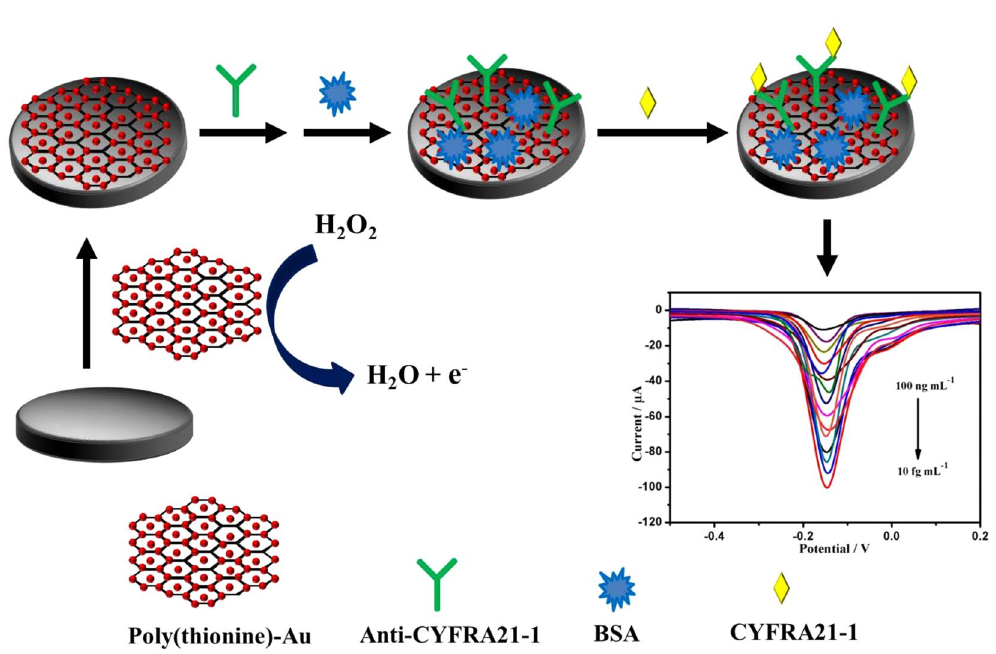
Figure 2. The poly(thionine)-Au nanocomposite exhibited strong redox activity at − 0.15 V ( A ), ameperometic response of poly(thionine)-Au for successive addition of 5 mM H 2 O 2 ( B ), and the EIS of bare GCE (curve a), GCE modified with poly(thionine)-Au (curve b) ( C ).